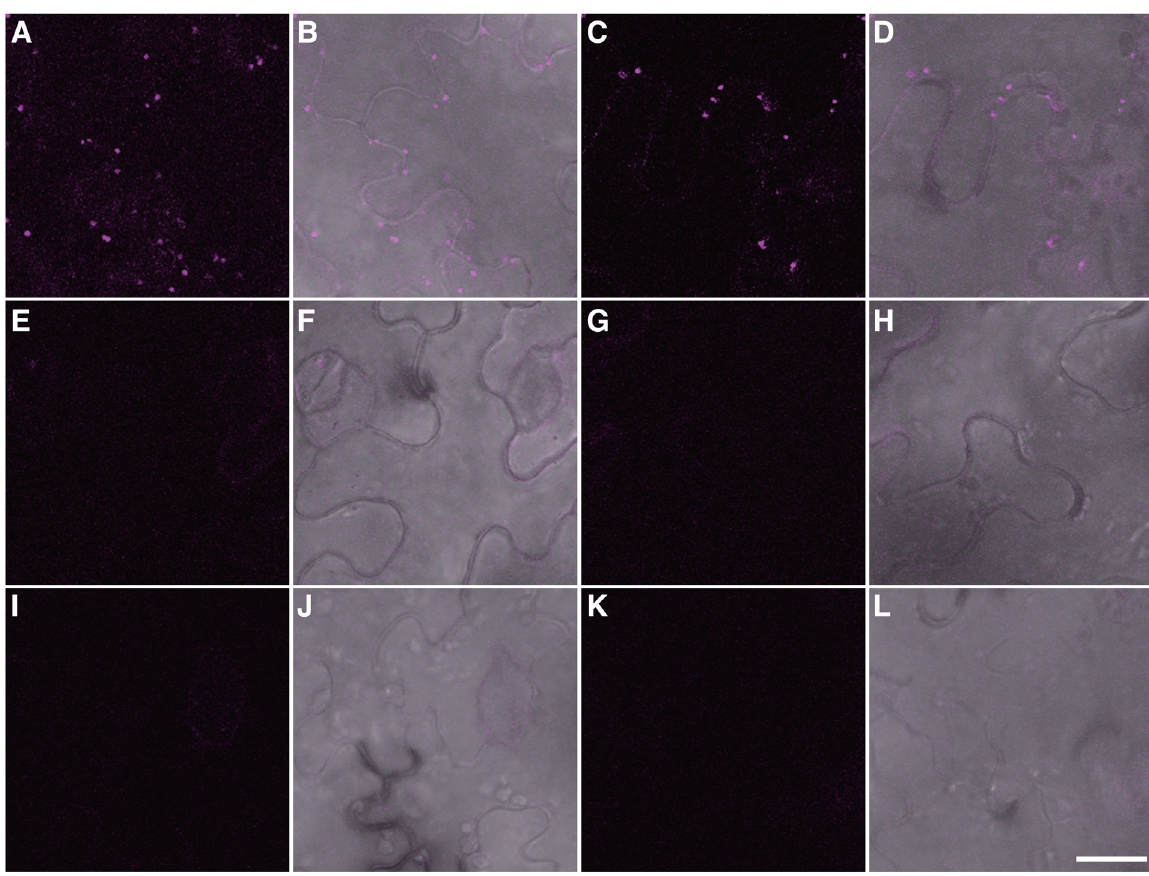
Fig 2. Detection of protein — protein interactions between PMP38 – PMP38 and PEX7 – PTS2 in tobacco leaves by Agrobacterium infiltration. Various combinations of fusion genes were introduced by Agrobacterium infiltration. (A, C, E, G, I and K) Detection of red fluorescent signals from reconstituted mRFP1. (B, D, F, H, J and I) Merged images of reconstituted fluorescent signals with differential interference contrast settings. (A, B) PMP38-nRFP with PMP38-cRFP. (C, D) nRFP-PEX7 with PTS2-cRFP. (E, F) nRFP-PEX7 with PMP38-cRFP. (G, H) PMP38-nRFP with cRFP-PEX12. (I, J) PMP38-nRFP with untagged cRFP. (K, L) nRFP-PEX7 with untagged cRFP. Bar: 20 μ m.